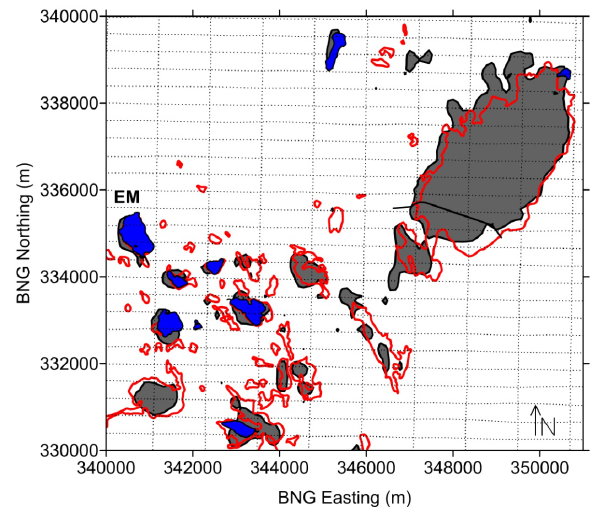
radiometric DOSE response is < 12 nGy·h − 1 . Black dots show airborne survey sampling along E–W flight lines (400 m line separation) and N–S tie lines (1,200 m line